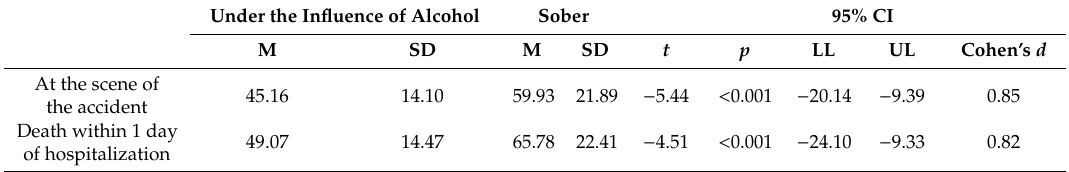
Table 6. Average age of victims by group and location of death.